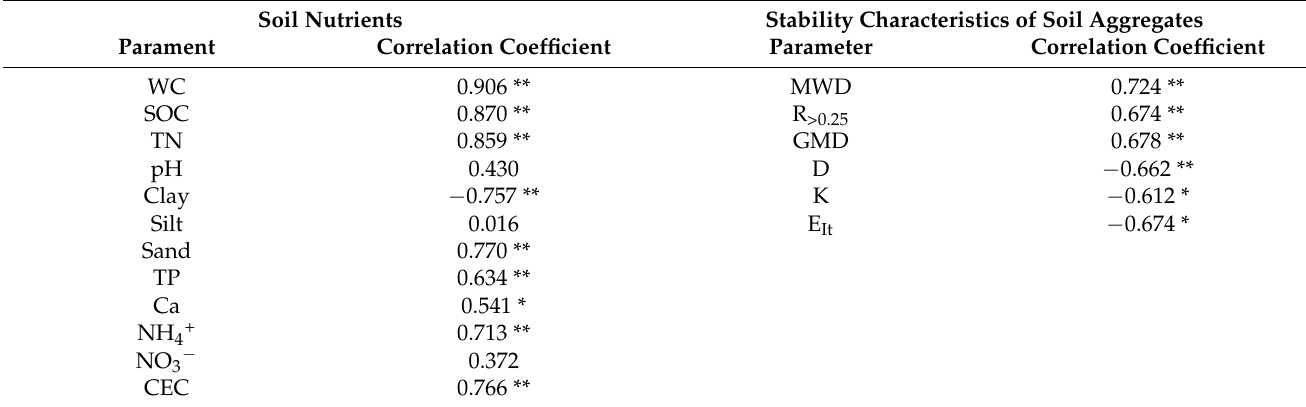
Table 4. Correlation between afforestation years and soil nutrients and soil aggregate